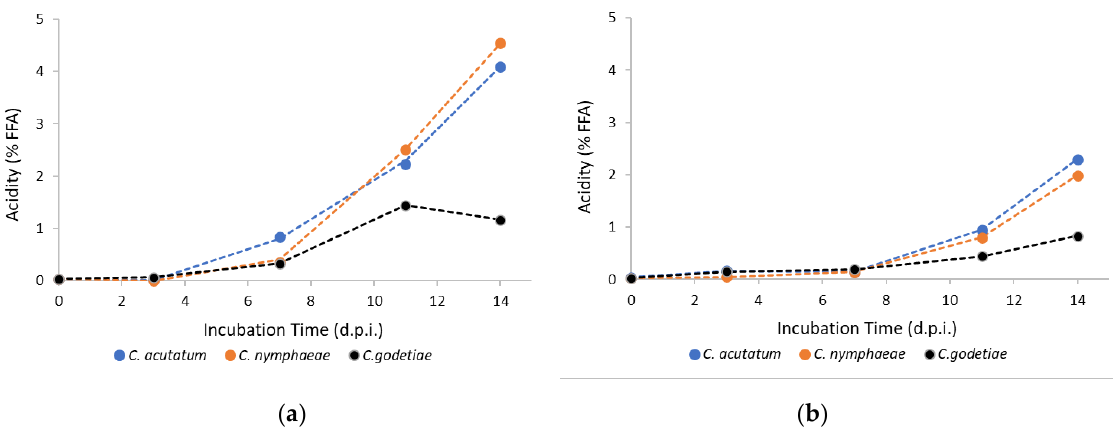
Figure 2. Acidity (% Free Fatty Acids) of Galega ( a ) and Cobrançosa VOO ( b ) obtained from fruits, after 3, 7, 11, and 14 days post-inoculation (d.p.i.) with Colletotrichum acutatum , C. nymphaeae and C. godetiae (STD variation range: 0.01–0.03; not seen in the figures).